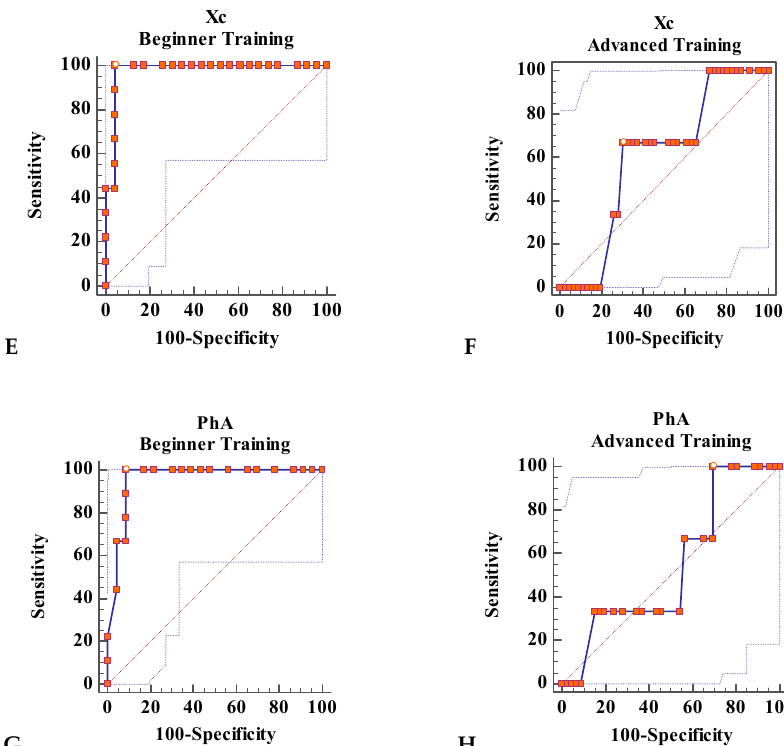
Figure 1. Receiver operating characteristics (ROC) curve analysis showing the area under curve (AUC) of body composition variables for the prediction of disordered eating attitudes (DEA). FFM: fat-free mass, Xc: reactance, PhA: phase angle. ROC curves are represented by the center stroke and the dotted lines are 95% confidence bounds. ( A ): FFM Sun in BT group, ( B ): FFM Sun in AT group, ( C ): FFM Slaughter in BT group, ( D ): FFM Slaughter in AT group, ( E ): Xc in BT group, ( F ): Xc in AT group ( G ): PhA BT group, ( H ): PhA in AT